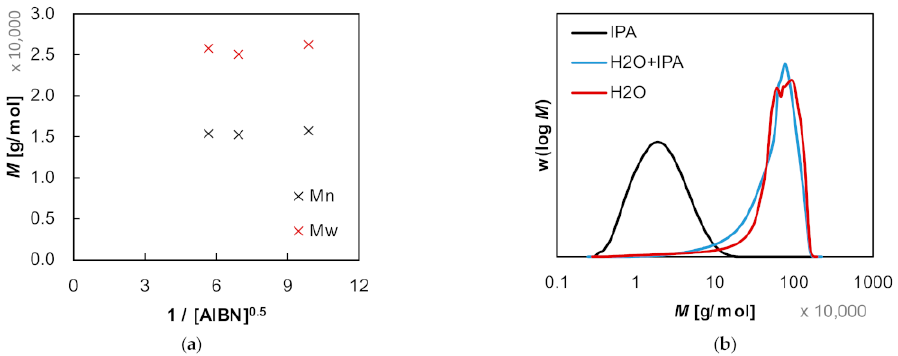
Figure 12. ( a ) Influence of different AIBN initiator concentrations on the weight and number average of molecular weight during polymerisation of acrylic acid in 2-propanol (150 g/L, 65 ◦ C). ( b ) Molar mass distribution during polymerisation of acrylic acid in pure isopropanol, water with isopropanol as the CTA (IPA/AA = 0.16) and pure water at 0.5 mol% initiator, respectively. Molecular weights were determined after a conversion of about 95%.